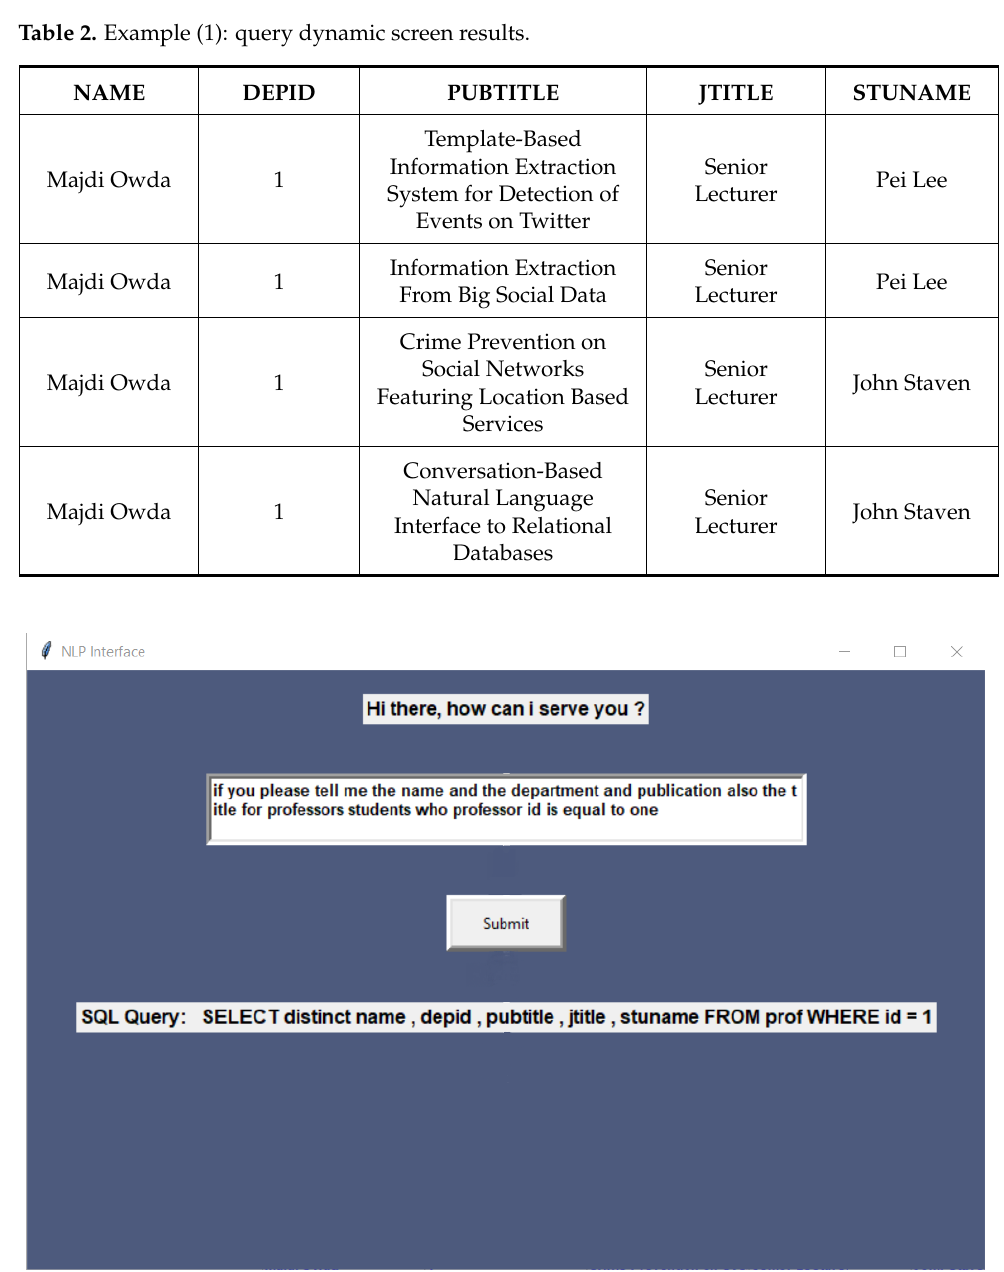
Figure 5. NLP Interface query dealing with another example (2) .